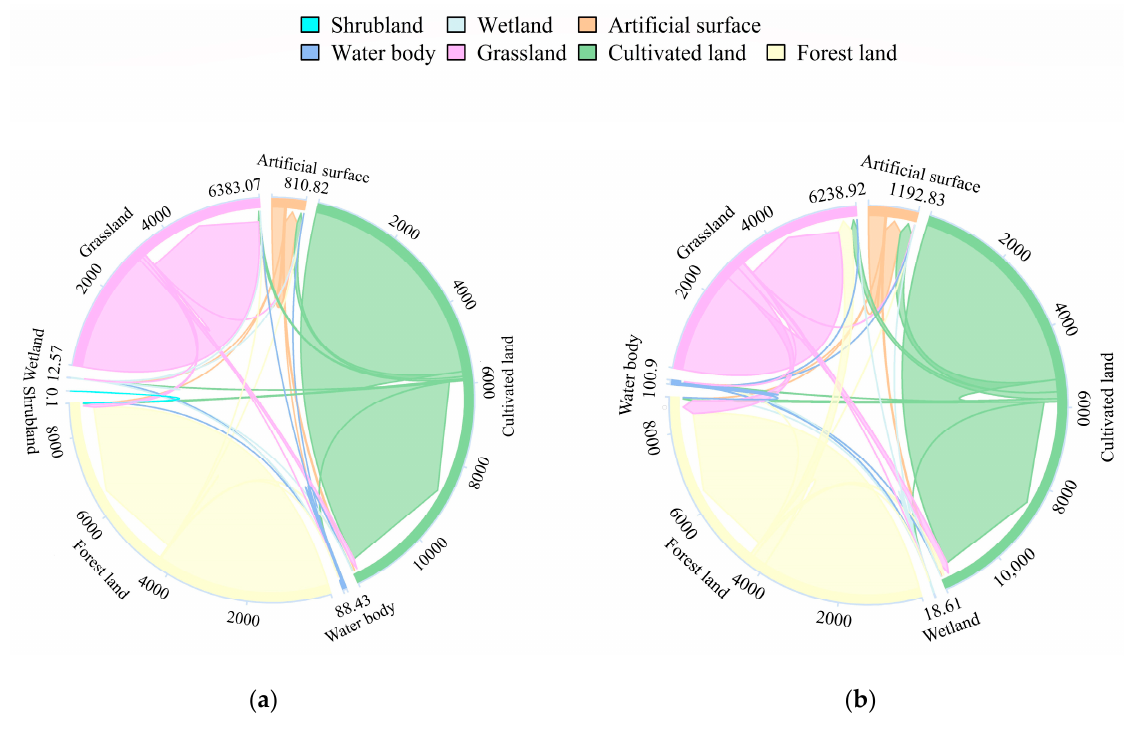
Figure 5. LUCC in Changzhi City between 2000–2010 ( a ), 2010–2020 ( b )